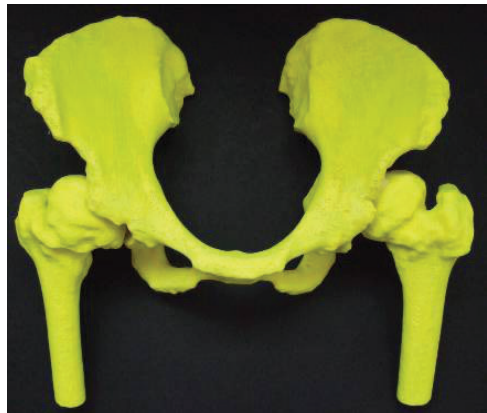
Figure 1. Pre FDM Dysplastic Hip